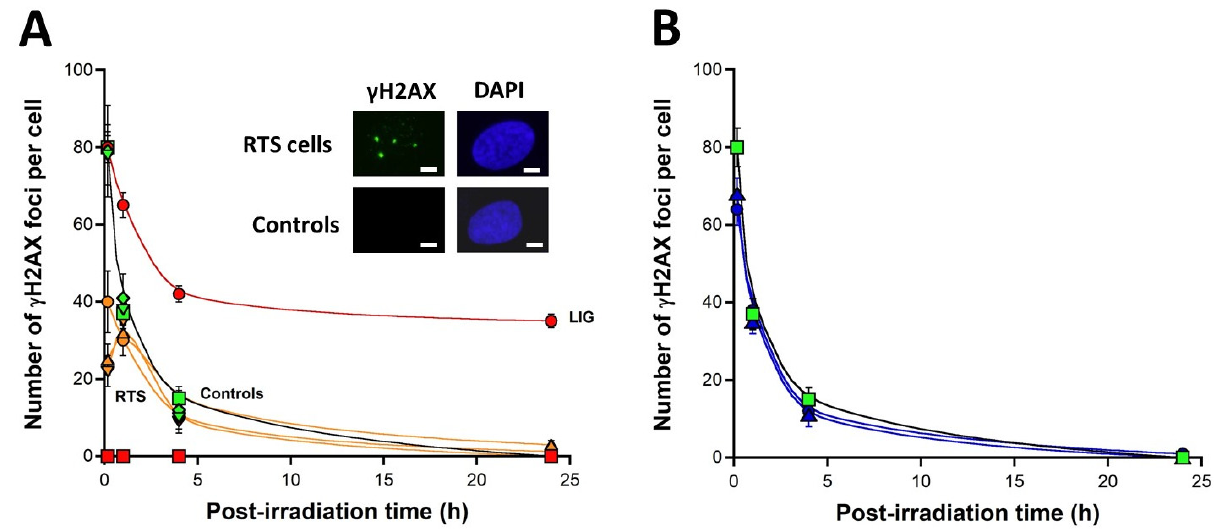
Figure 3. Kinetics of γ H2AX foci in RTS fibroblasts. Anti- γ H2AX immunofluorescence was applied to ( A ): the radioresistant controls (green symbols: 1BR3, squares; MRC5, diamonds; Hs27, inverted triangles), the hyper-radiosensitive LIG4 -mutated 180BR (red circles), and the three RTS (orange symbols: 81CLB, circles; AG17524, triangles; AG18371 inverted triangles) fibroblast cell lines and to ( B ): 2 fibroblast cell lines from parents of RTS patients (blue symbols: AG18466, circles and AG18373, triangles) in addition to the radioresistant 1BR3 controls (green squares). The number of γ H2AX foci was plotted against the post-irradiation time. Each plot represents the mean ± SEM of three replicates. For clarity, only the 1BR3 data, the 81CLB, AG17524, and AG18371 data, the 180BR data, and the AG18466 and AG18373 data were fitted. Data were fitted to the Bodgi’s formula [58]. The insert in panel A shows a representative example of γ H2AX foci assessed 24 h post-irradiation in one RTS fibroblast cell line (81CLB) and one radioresistant control (1BR3), with the corresponding DAPI counterstaining. The white bar corresponds to 5 µm.